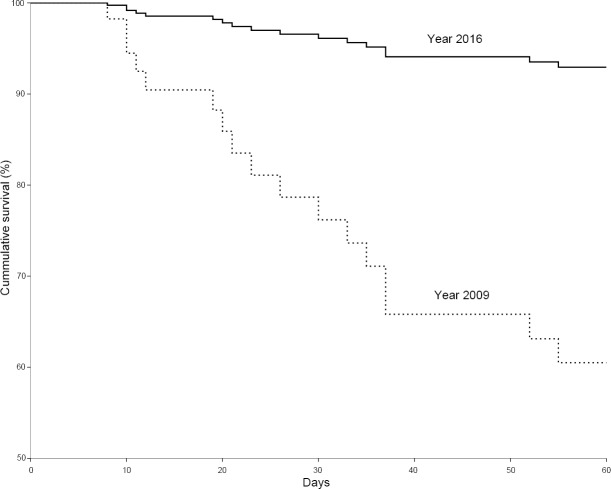
Cox proportional hazards model cumulative survival curve for patients with H1N1 acute respiratory failure each year (the solid line represents patients treated in 2016; the dotted line represents those treated in 2009).